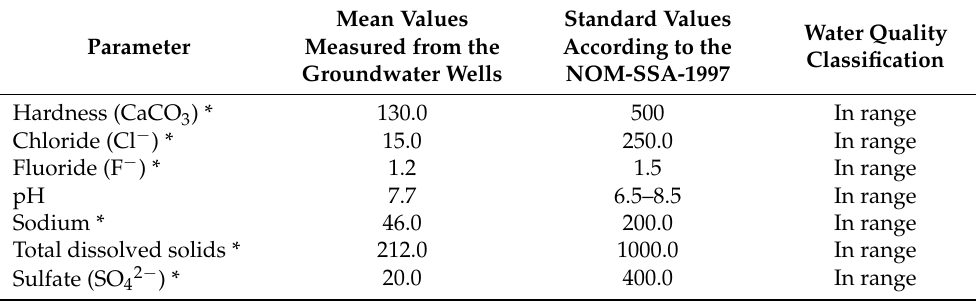
Table 3. Water quality classification based on the Mexican standard and the measured